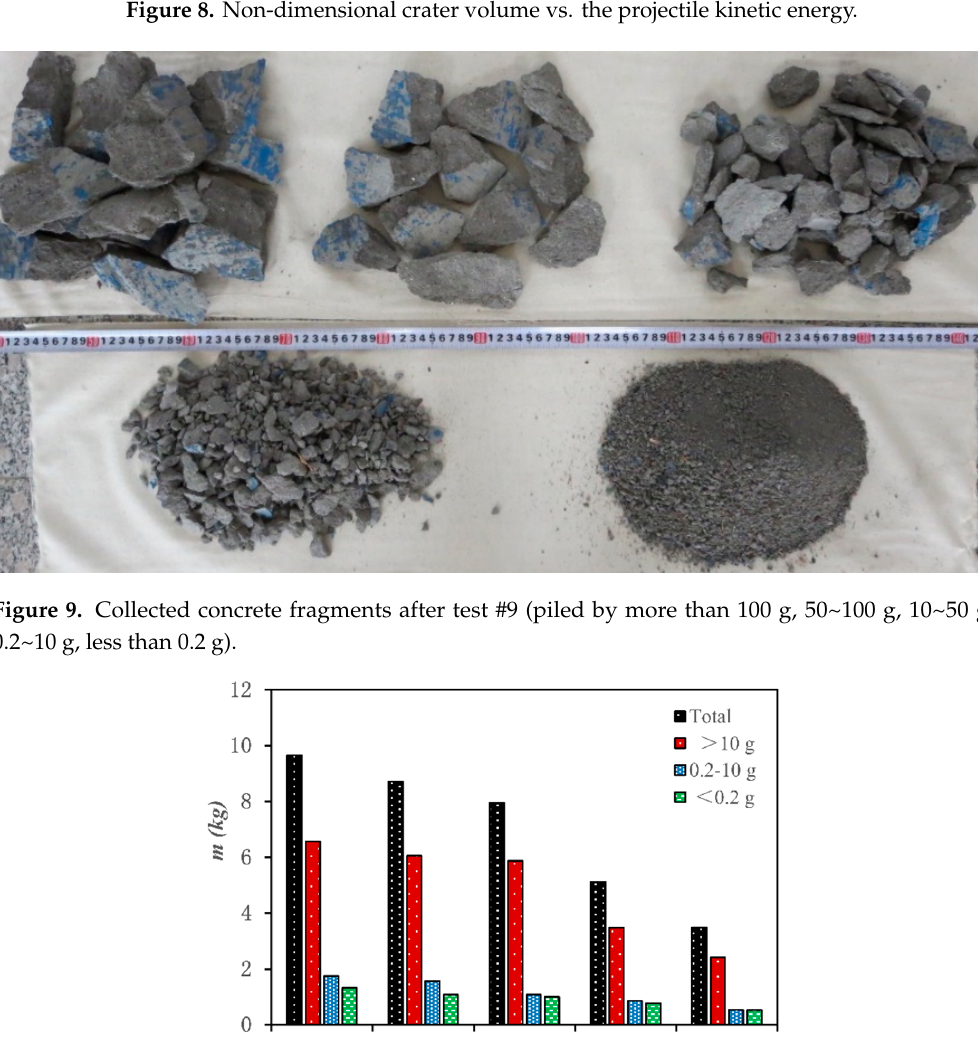
Figure 9. Collected concrete fragments after test #9 (piled by more than 100 g, 50~100 g, 10~50 g, 0.2~10 g, less than 0.2 g).